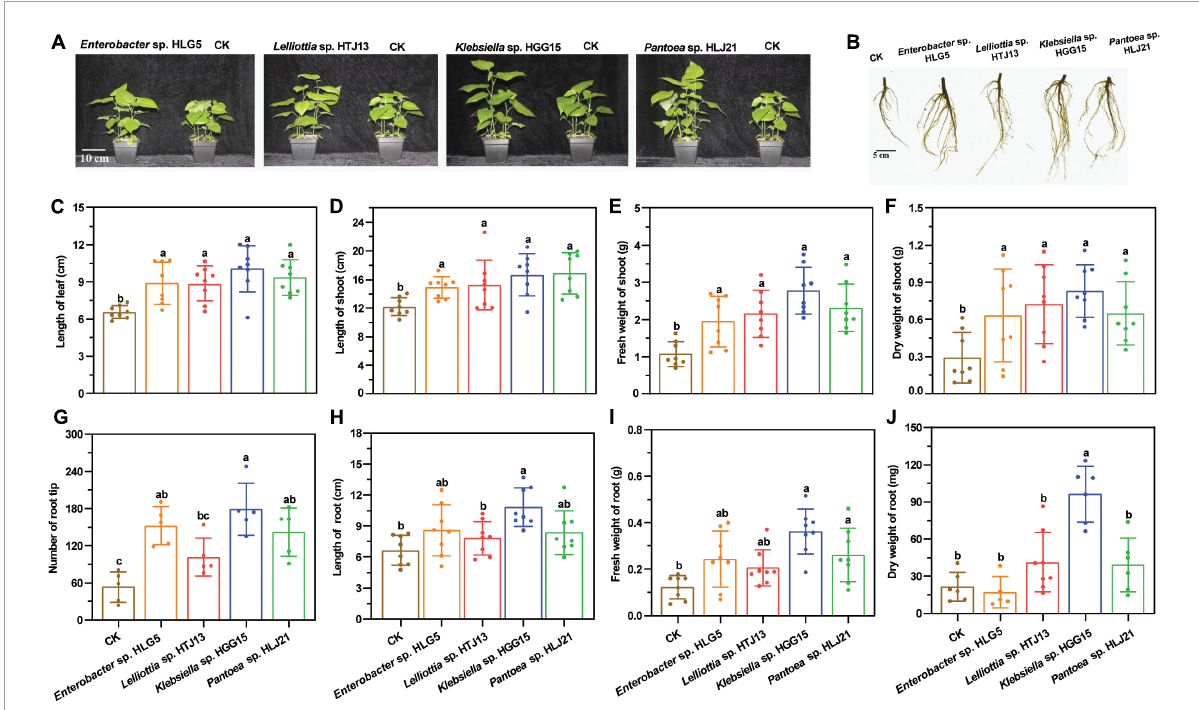
FIGURE1 The growth promotion ability of potential four PGPBs on mulberry seedlings after 30-day inoculation. (A) The growth status of mulberry applied with the 1 × 10 7 CFU/mL bacterial suspensions. (B) The representative photograph of mulberry root architectures. (C) Length of mulberry leaf. (D) Length of mulberry shoot. (E) Fresh weight of mulberry shoot. (F) Dry weight of mulberry shoot. (G) Number of mulberry root tip. (H) Length of mulberry root. (I) Fresh weight of mulberry root. (J) Dry weight of mulberry root. Values represented the mean ± standard deviation of replicates ( n = 8). Different letters indicated statistical differences using Tukey’s one-way ANOVA ( P <